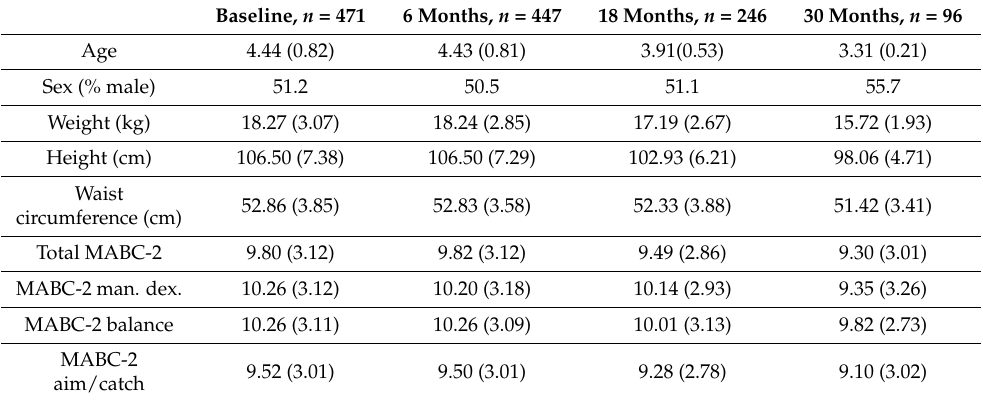
Table 3. Drop-out analyses. Comparison of baseline values at baseline and the three follow-up samples, mean (SD).